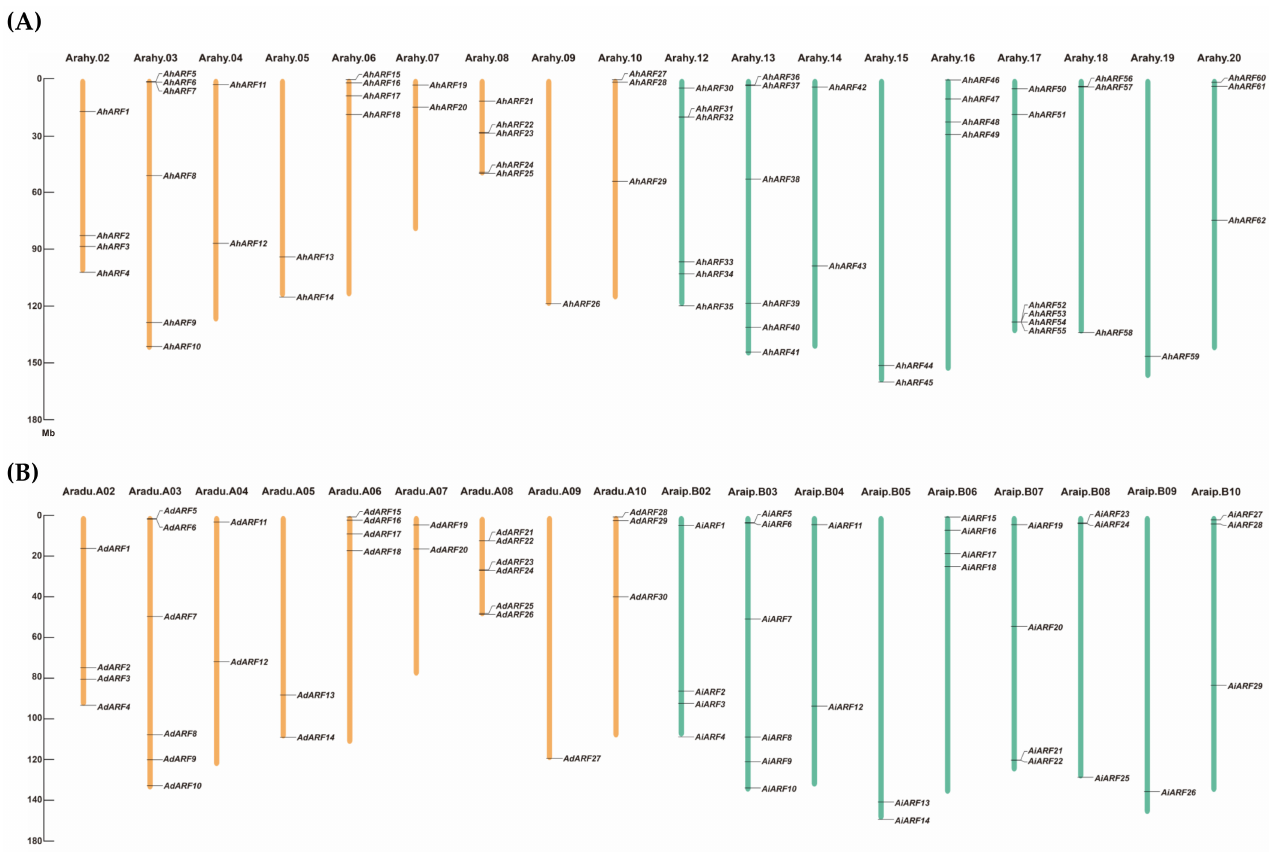
Figure 1. Chromosome distribution of ARFs in cultivar ( A ) and wild ( B ) peanuts. Chromosomes belong to the A sub-genome of A. hypogaea (Arahy.02–10) and their homologues from A. duranensis are colored in yellow, while the chromosomes that belong to the B sub-genome of A. hypogaea (Arahy.12–20) and their homologues from A. ipaensis are colored in green. Chromosomes that do not contain ARF s and ARF s located on the scaffold are not